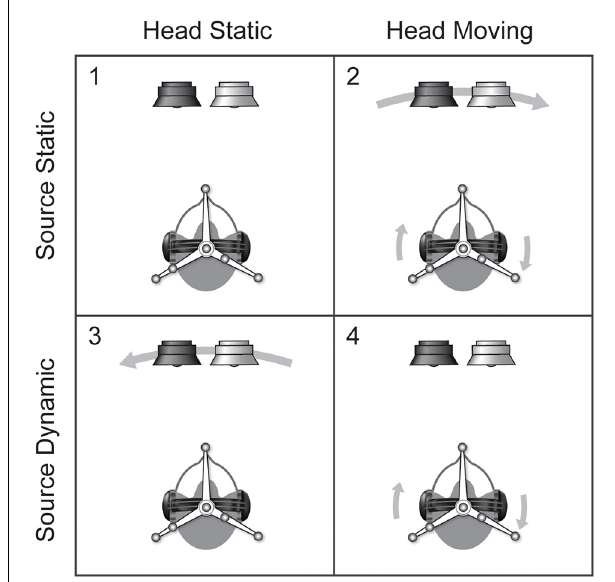
FIGURE 2 | The 2 × 2 experiment design. Tests of the minimum audible angle were conducted in four conditions: (1) listeners were asked to remain static and the signal was not moved, (2) listeners were asked to turn their heads and the signal moved with them, (3) listeners were asked to remain static and the signals were moved, and (4) listeners were asked to turn their heads and the signal was adjusted so as to appear to remain still with respect to the world.